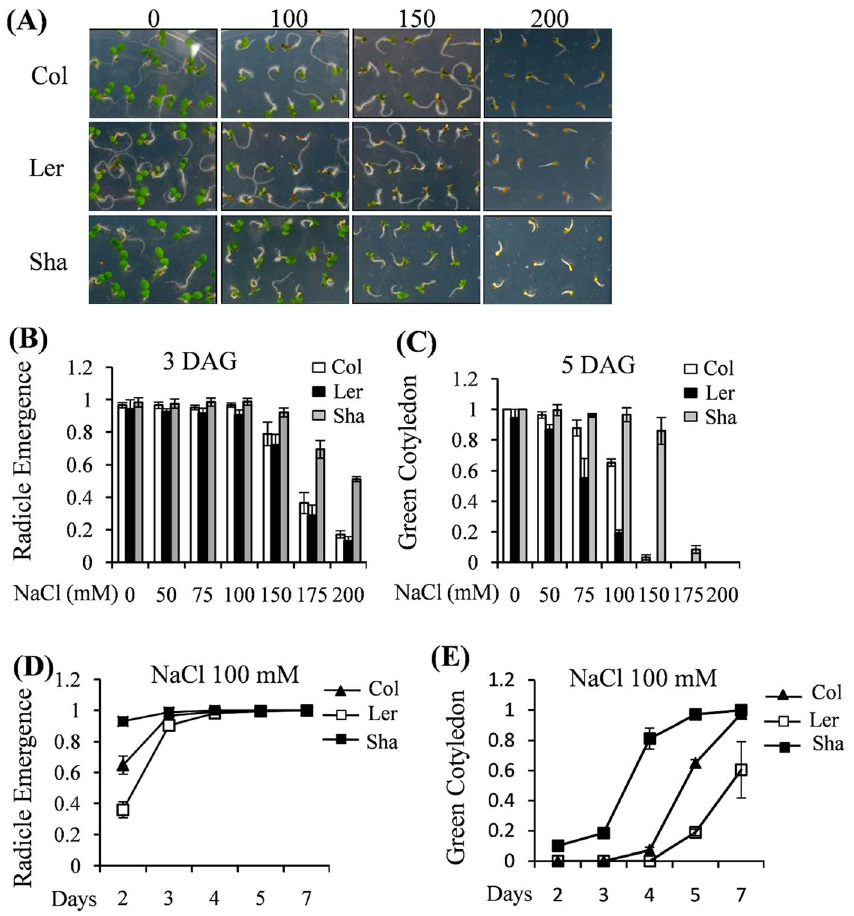
Figure 1. Comparison of seed germination rates among Col, Ler and Sha under salt stress treatment. (A) Plants were grown on MS plate supplied with the indicated concentrations of NaCl (mM). Photos were taken after 5 DAG (Days-After-Germination). Bar=1 cm. (B) & (C) Germination rates were compared with various concentrations of NaCl. Germination rates were analyzed by counting the number of emergenced radicles after 3 DAG on the indicated concentrations of NaCl in (B) or by counting the number of green cotyledons after 5 DAG in (C). The values indicated means + SEs of four independent experimental repeats (n=30). (D) & (E) The kinetics of germination time among Col, Ler and Sha were analyzed with the same concentration of NaCl (100 mM). Germination rates were determined by counting the number of emergenced radicles (D) and green cotyledons (E) at the indicated time points. The values indicated means + SEs of four independent experimental repeats (n=30).